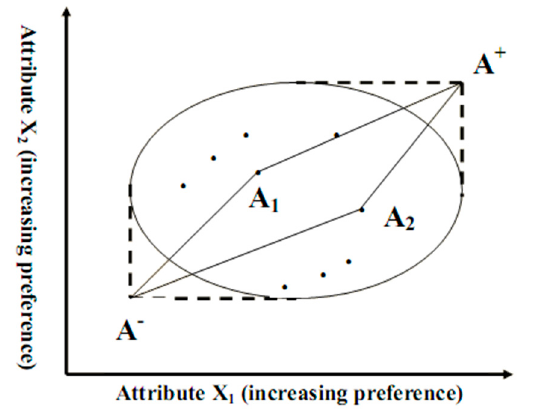
Figure 1. Basic concept of TOPSIS method (A + : Ideal point, A − : Negative—Ideal